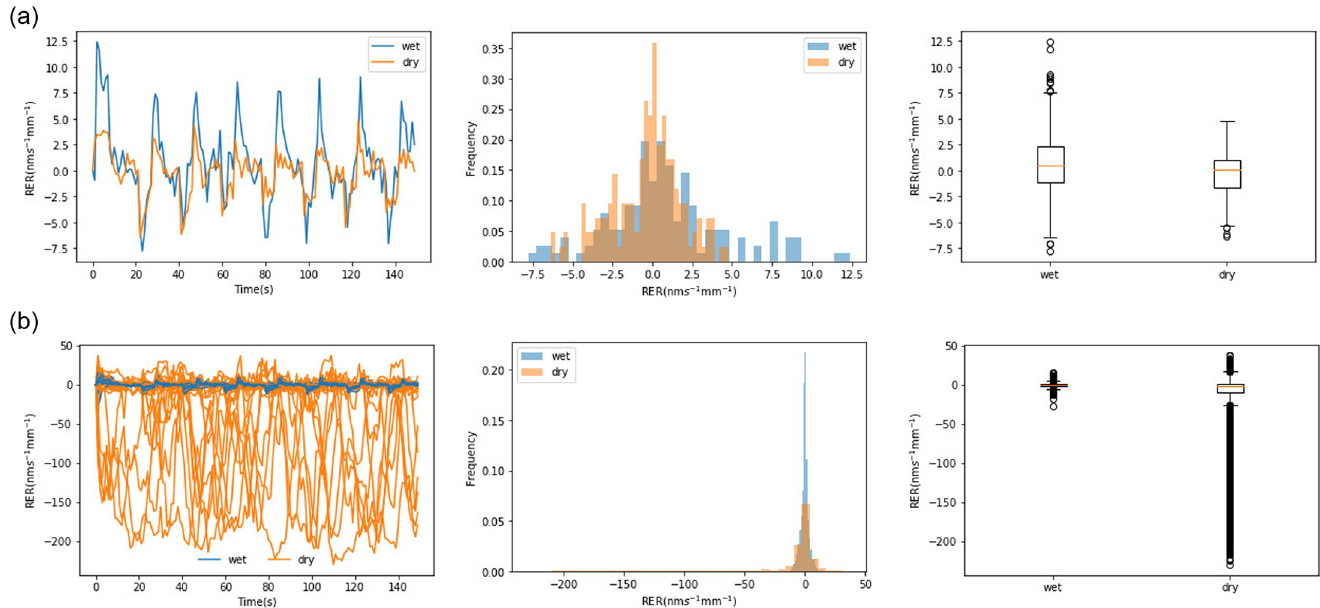
Fig 6. A comparison of the RER values of the roots’ in two kinds of environments. ( a ) A root elongation rate and its histogram, plus a box-and-whisker plot. ( b ) Theelongation rate of all the roots and their histogram, plus a box-and-whisker plot.